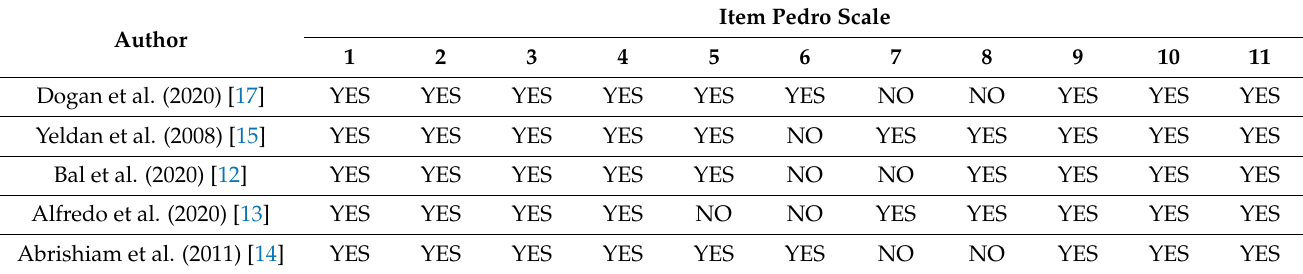
Table 3. Results of PEDro